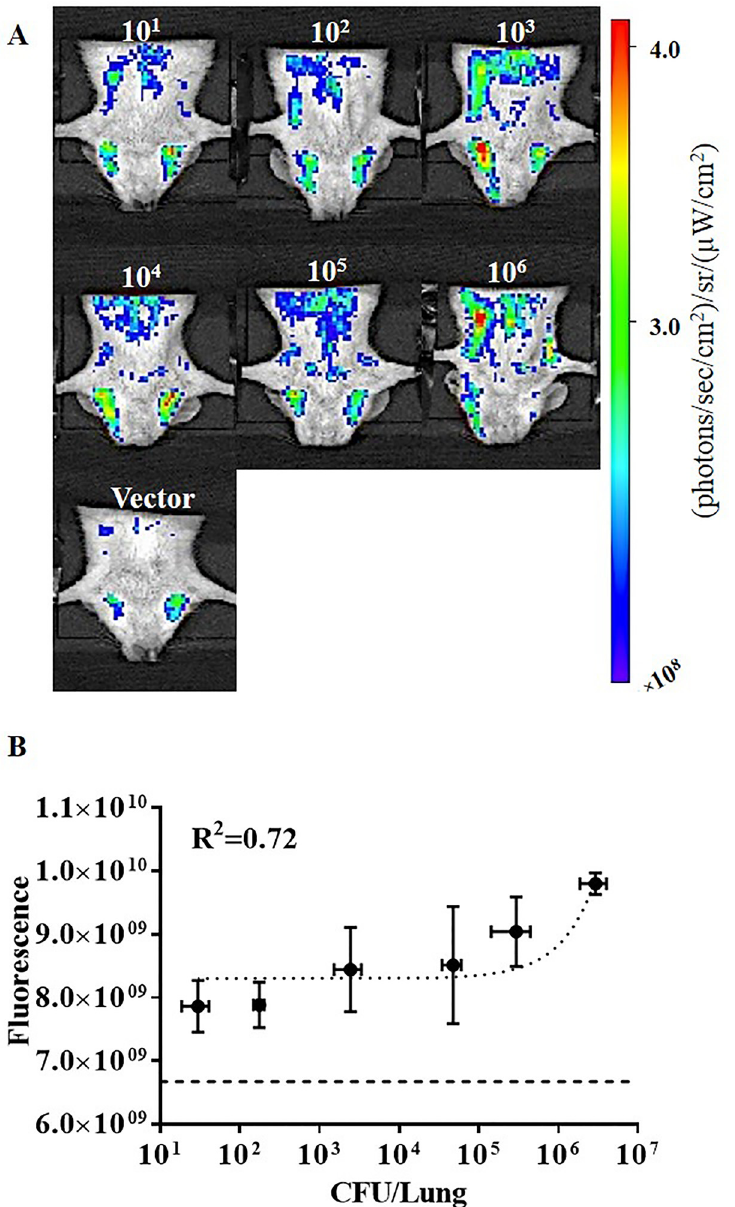
(tdTomato expressing BCG strain) and 10 5 CFU BCG39 (BCG containing the same vector that does not express tdTomato (Vector)). (B) Correlation of fluorescence signal in mouse whole-body images versus CFU in lung homogenates from the same animal. Error bars represent the standard error for each sample group. Horizontal dashed line in (B) represents the average signal for the vector control group. All images and measurements represent tdTomato contribution to signal after spectral